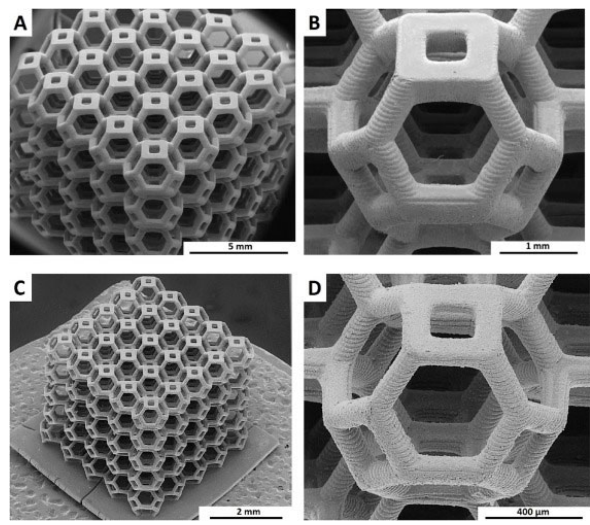
Fig. 7 SEM micro-graphs of (A, B) dried and (C, D) pyrolysed samples. Reproduced with permission from Ref. [93], © Elsevier Ltd. 2017.